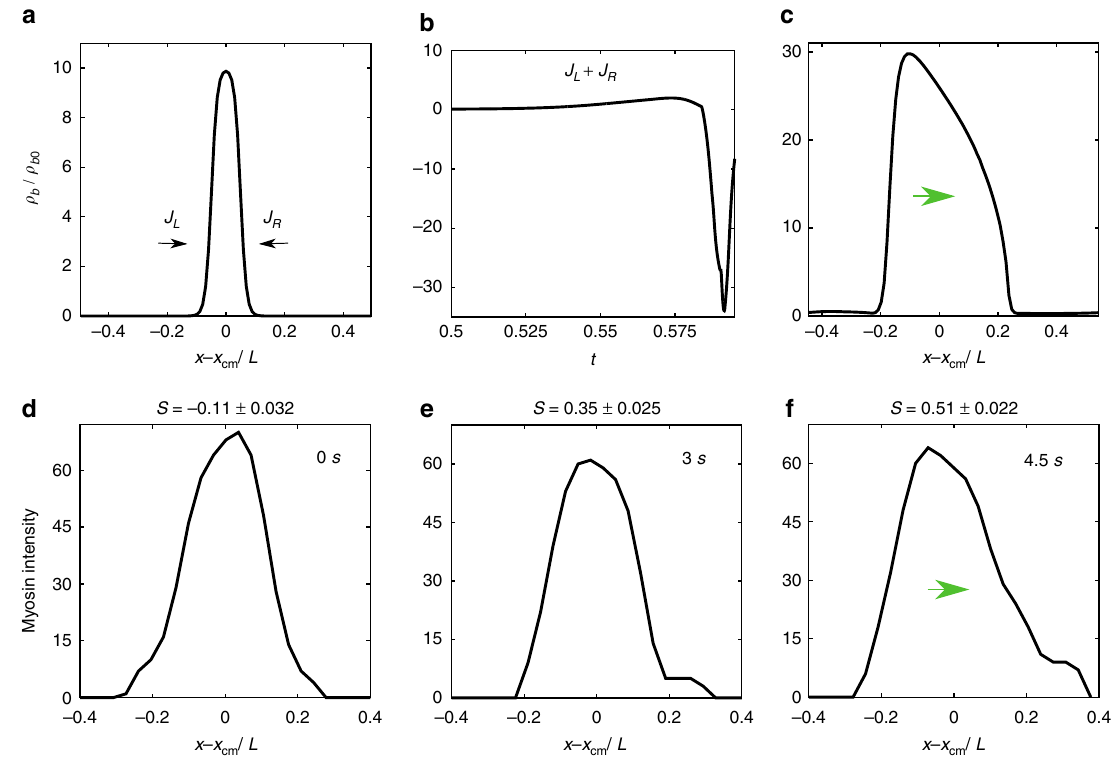
Fig. 4 Time evolution of ρ b , the density pro fi le of bound myosin in a cluster prior to movement: a Prior to movement the myosin density pro fi le is seen to be symmetric, following which we compute the instantaneous left-right fl uxes, J L,R of myosin drawn into it. b Time evolution of the algebraic sum J L + J R , shows that after a while, there develops a net fl ux in one direction as a precursor to the asymmetric traveling front. c Emergence of the asymmetric traveling front which moves towards the right in a shape-invariant manner. d – f Myosin intensity pro fi les from experiments, which shows how an initial stationary symmetric myosin pro fi le at t = 0, fi nally evolves to an asymmetric pro fi le at t = 4.5 s, which then travels to the right. The degree of shape asymmetry of the pro fi les is described by the skewness S , the standard error of mean(s.e.m.) reported is due to projection of the images to one